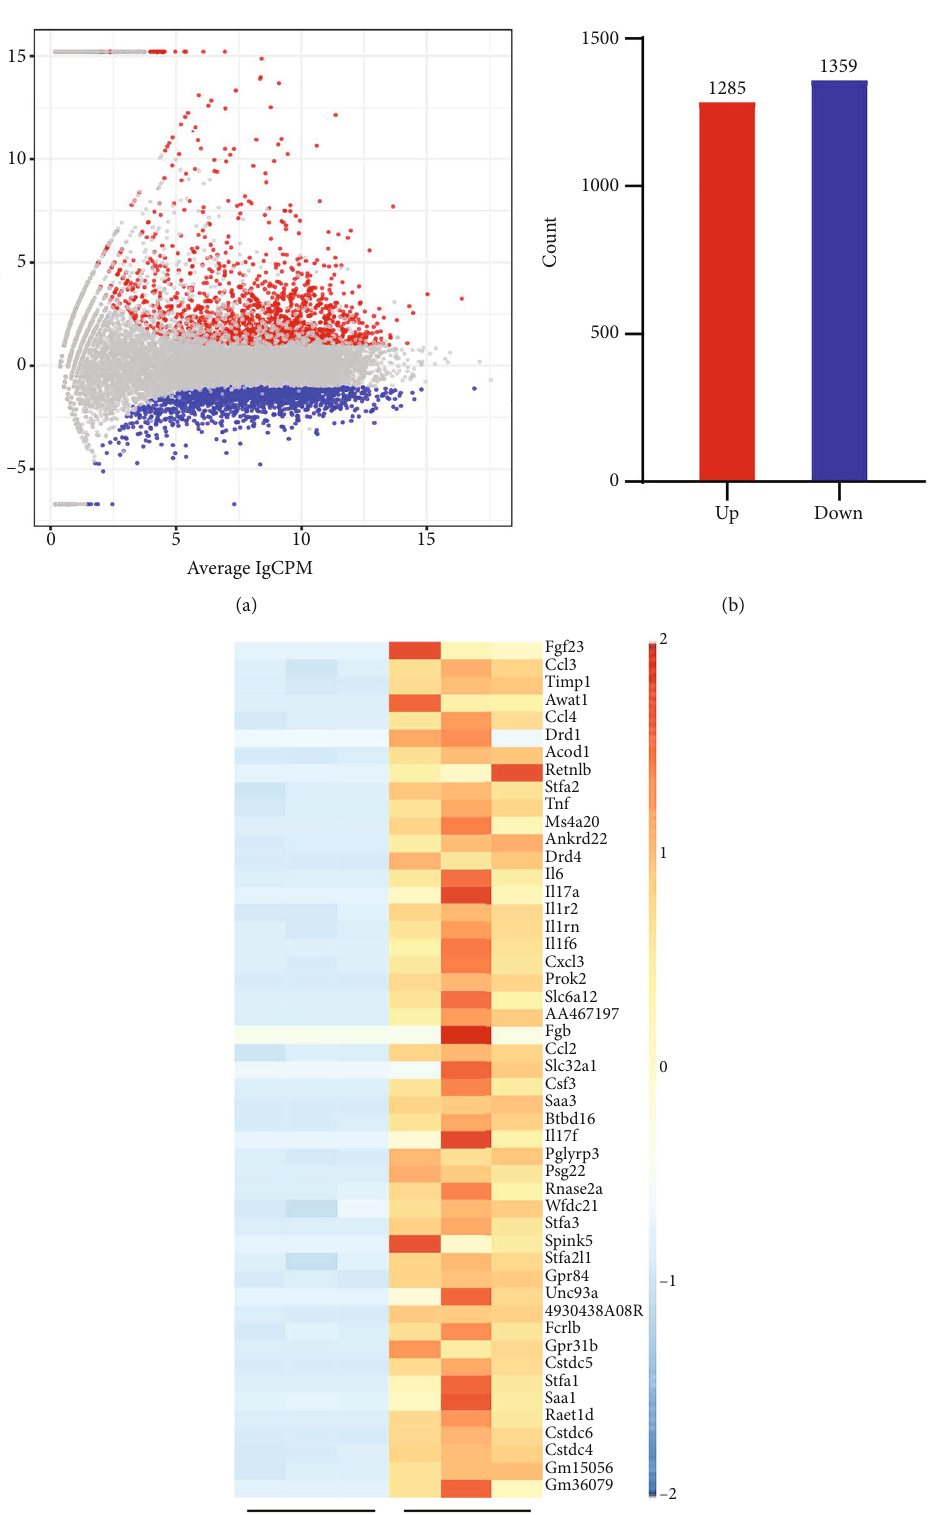
Figure 2: Di ff erentially expressed genes between K. pneumoniae -infected lungs (48 hours post infection) and normal lungs. (a) Volcano plot of di ff erentially expressed genes. Di ff erentially expressed genes were shown in red plots ( > 2 fold upregulated), blue plots ( > 2 fold downregulated), and gray plots (nonsigni fi cant di ff erence). (b) Counts of upregulated (red) and downregulated (blue) genes. (c) Heatmap of top 50 upregulated genes sorted by fold